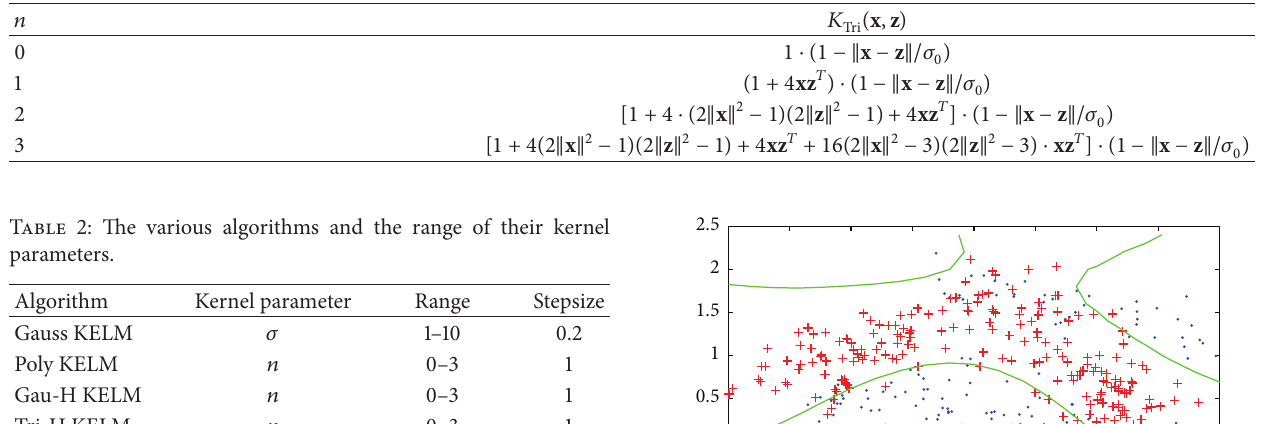
Table 1: List of the Generalized Triangular Hermite kernel function up to the 3rd order.